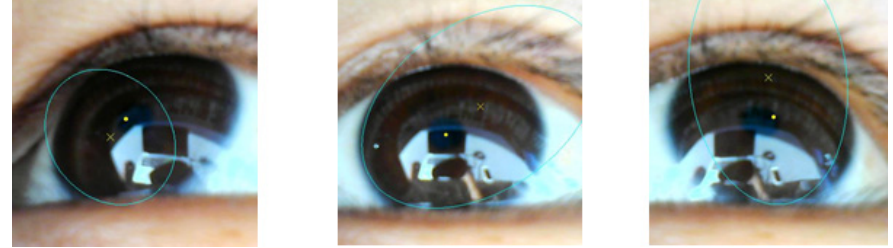
Figure 1. Visible-light pupil tracking results by the previous ellipse fitting-based method.